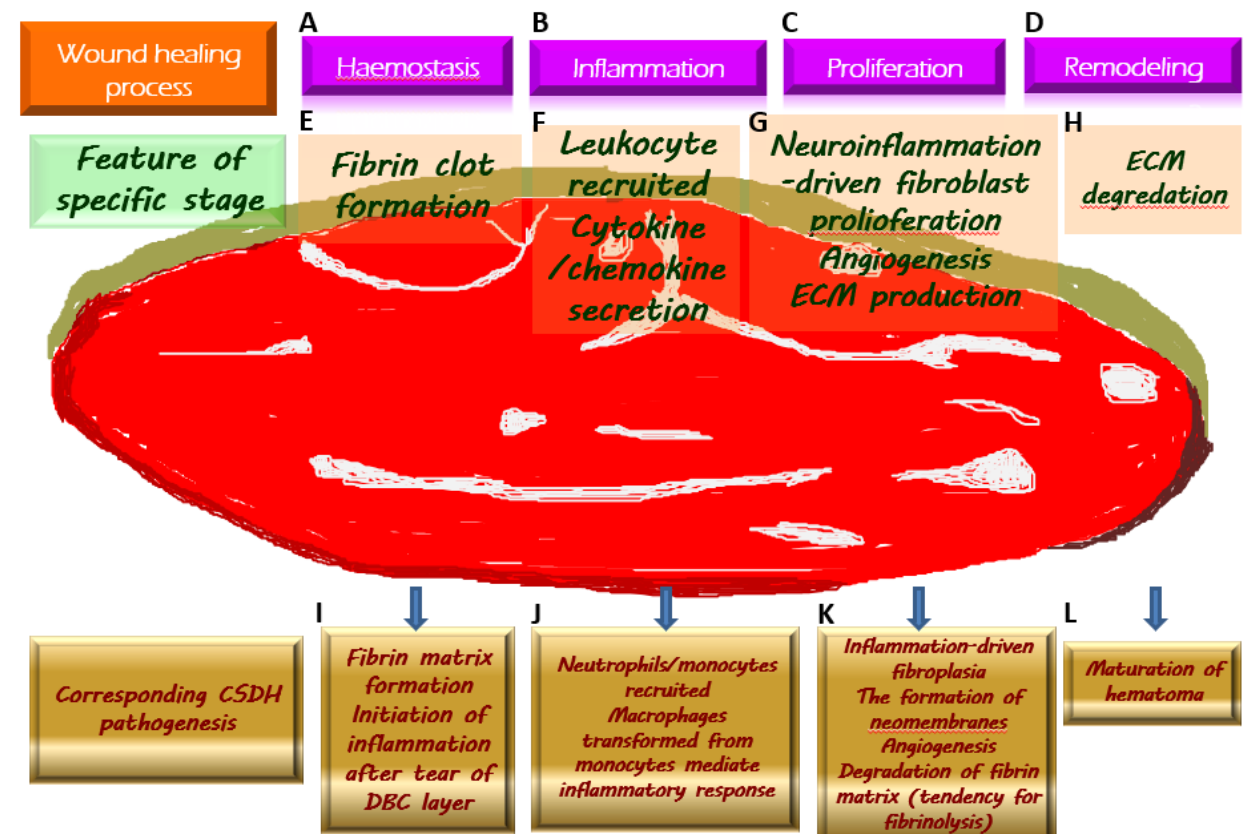
Figure 2. Chronic subdural hematoma (CSDH) depicted as an intracranial wound tending to not heal properly. Once a wound is created, the physiologically protective mechanism undergoes hemostasis ( A ) and the formation of fibrin clot ( E ), which serves as an extracellular matrix (ECM) for the migration of immune cells recruited by pro-inflammatory cytokines ( F ) along the subsequent inflammatory response ( B ). During the proliferative phase ( C ), fibroblasts undergo proliferation while producing ECM and generating neovascularization to provide for the nutritional needs of the cells ( G ). When the wound is about to heal, the ECM is gradually degraded by the remodeling process ( D ) and is replaced by scar tissue ( H ). Regarding the formation of CSDH, the tear of the dural border cell (DBC) layer subtly corresponds to the creation of a wound. Fibrin matrix formation provides a comprehensive explanation for the presence of coagulation signals in the effusion of CSDH ( I ). Subsequently, under the vicious cascade of inflammatory response ( J ), fibroblast proliferation, and ECM generation contribute to neomembrane production. Angiogenesis takes place in the emerging inner and outer membranes, and the newly formed vessels have fragile walls, resulting in repeated microbleeding. In addition, during this proliferative phase, the tissue that resembles granulation replaces the originally generated fibrin matrix, thereby leading to a tendency of fibrinolysis ( K ). With the maturation of the inner and outer membranes in CSDH, the neovascularization is less likely to rupture and bleed, indicating the coming wound remodeling and eventual stabilization of CSDH ( L ).